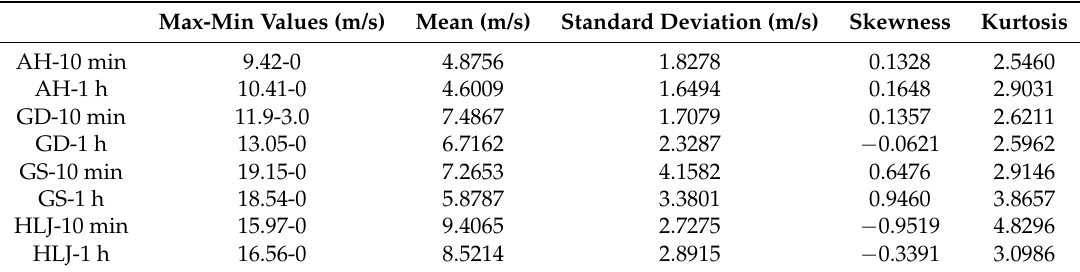
Figure 3. Wind speed series with 1 h interval at four sites in China: ( a ) AH; ( b ) GD; ( c ) GanSu (GS) and ( d ) HLJ. Table 2. Descriptive statistics of wind speed data at four sites in